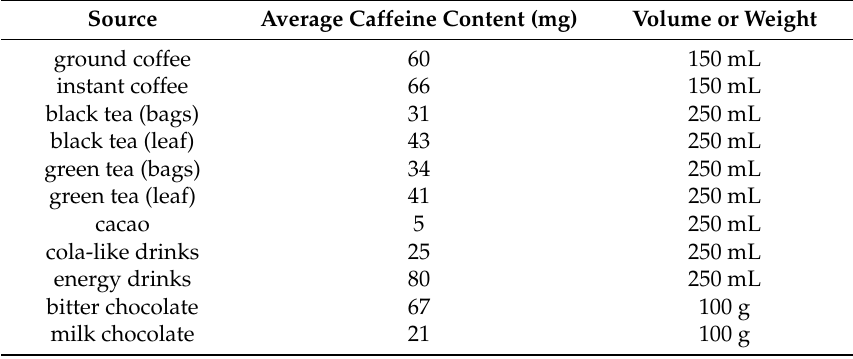
Table 1. Caffeine content of food and beverage sources, used in study.